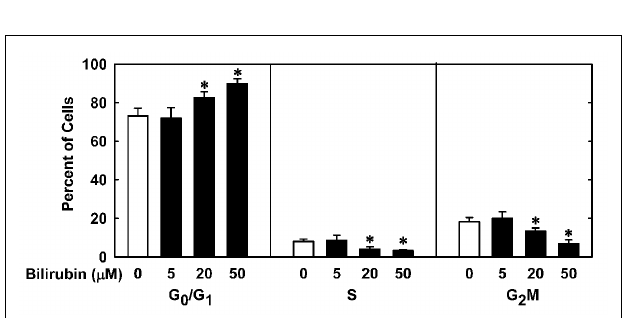
FIGURE 4 | Bilirubin inhibits cell cycle progression of human vascular SMCs. Cells were treated with serum (20%) in the absence or presence of bilirubin (0–50 μ M) for 24h. Results are means ± SEM ( n = 4). *Statistically significant effect of bilirubin.